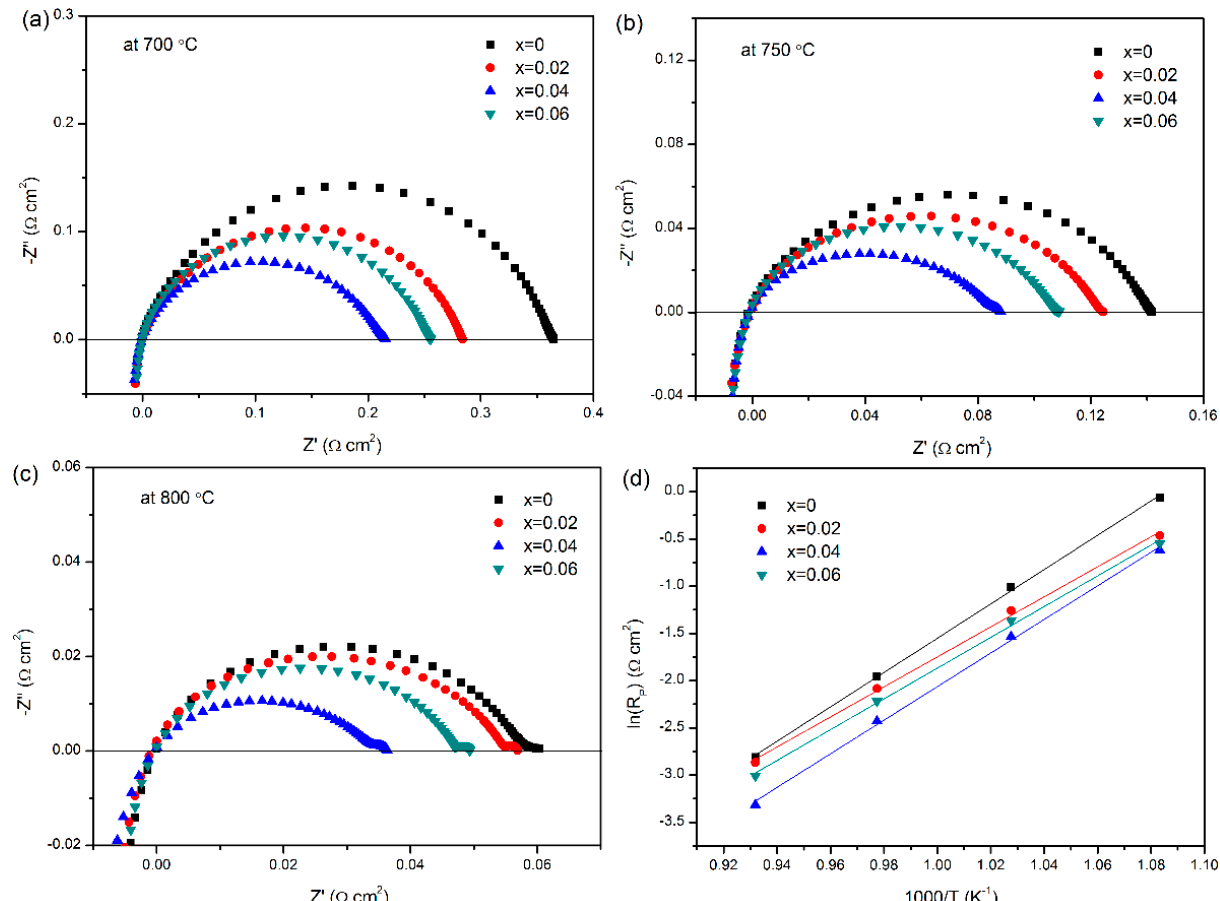
Figure 6. EIS of the LBCM x ( x = 0–0.06) cathodes at ( a ) 700 °C, ( b ) 750 °C, and ( c ) 800 °C under open-circuit conditions. ( d ) Arrhenius plots of the R P for LBCM x ( x = 0–0.06) from 600 °C to 800 °C.